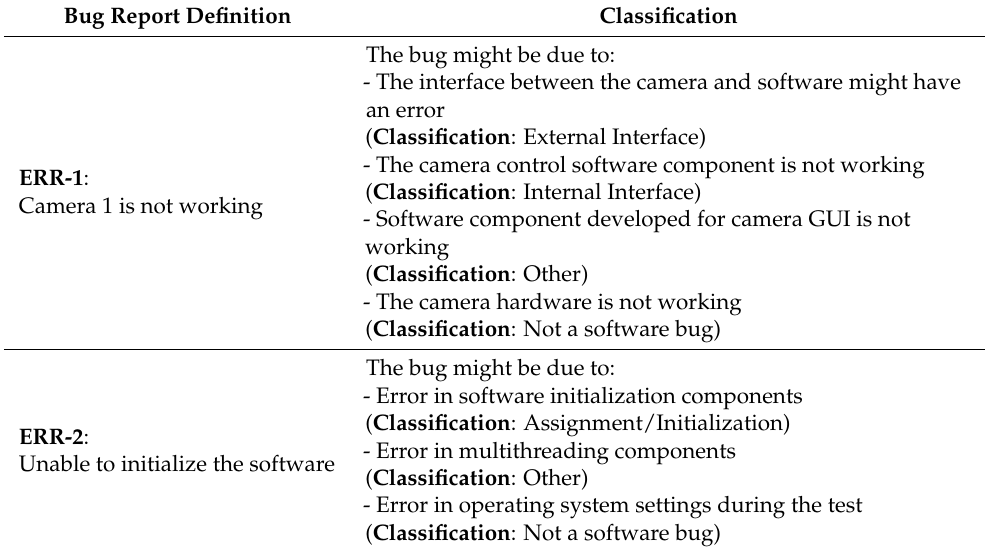
Table 7. Sample bug reports in